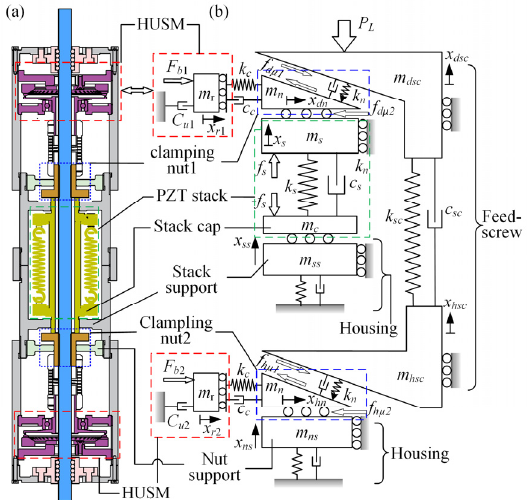
Figure 4. The actuator model. ( a ) CAD model; ( b ) dynamic model.